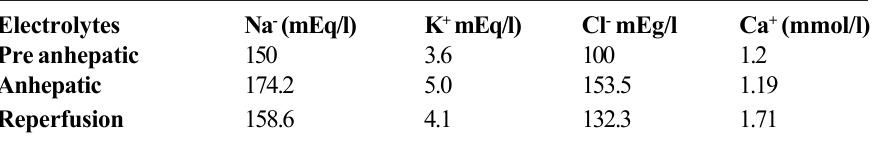
TABLE 5 - Serum electrolytes in the recipients Electrolytes